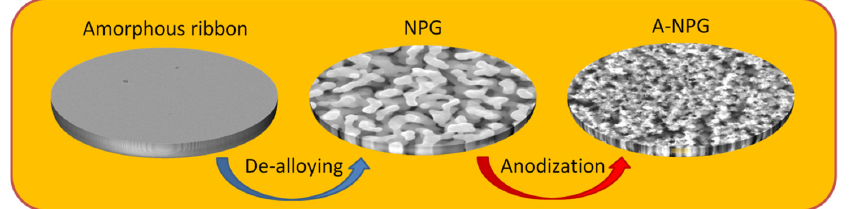
Figure 1. Engineering step procedure for A ‐ NPG: the amorphous ribbon is dealloyed to obtain NPG. Then, anodization of NPG in 0.3 M oxalic acid solution leads to anodized NPG.